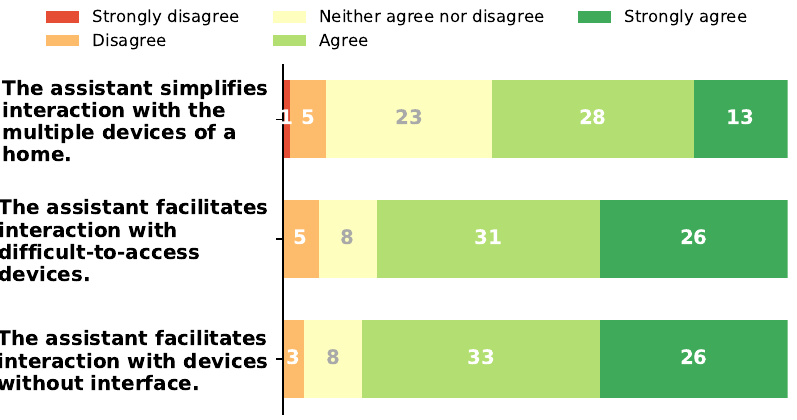
Figure 4. Results for the questions concerning the interaction with the home’s devices using our